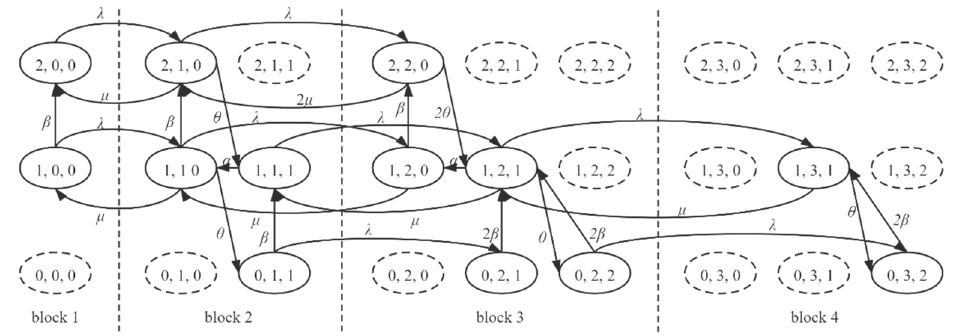
Figure 7. Continuous-time Markov chain (CTMC) of a case where S = 1, d = 1, K = 1. The dashed-line states are pseudo-states.